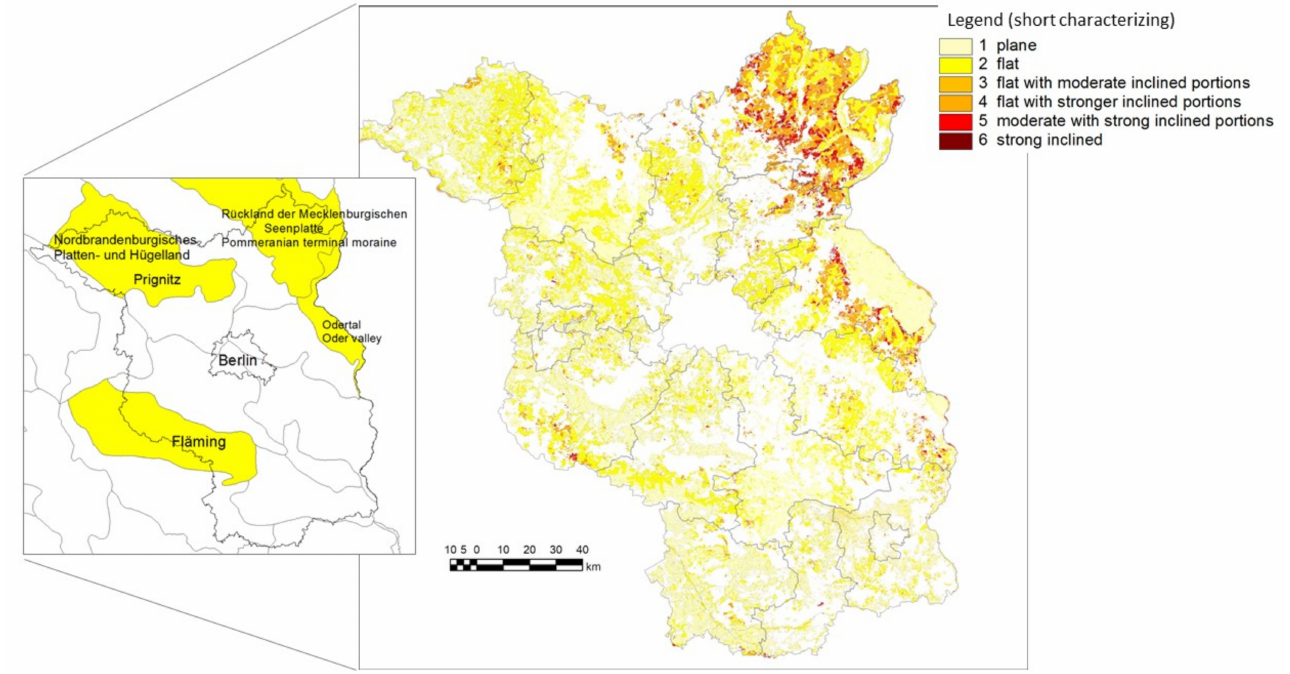
Figure 2. Slope association type of parcels in Brandenburg based on DEM1 with NUTS3 borderlines; © GeoBasis-DE/LGB (2020), https://www.govdata.de/dl-de/by-2-0 (accessed on 14 October